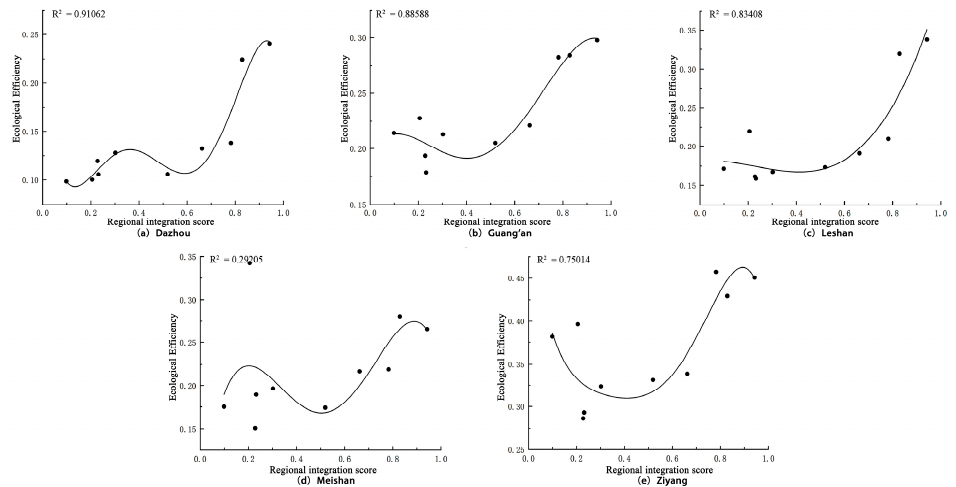
Figure 5. The regional integration fluctuation of the CCUA has improved the EEs of some cities from 2011 to 2020.